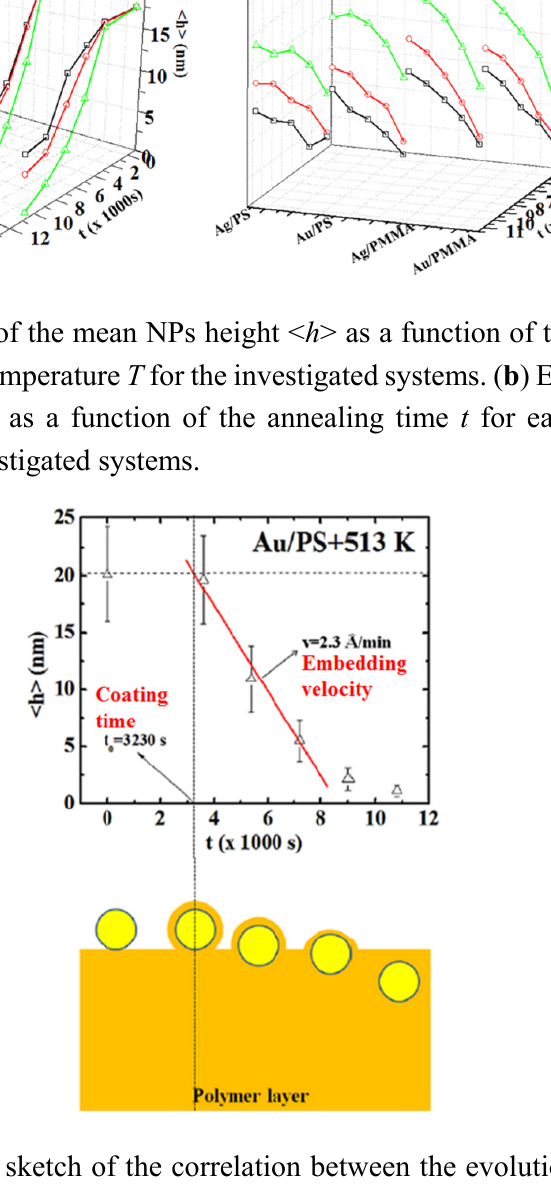
Figure 16. Evolution and sketch of the correlation between the evolution of < h > vs. t and the embedding process stages. The particular case of Au/PS at 513 K is taken as an example. (Reproduced with permission from [65], Copyright Springer